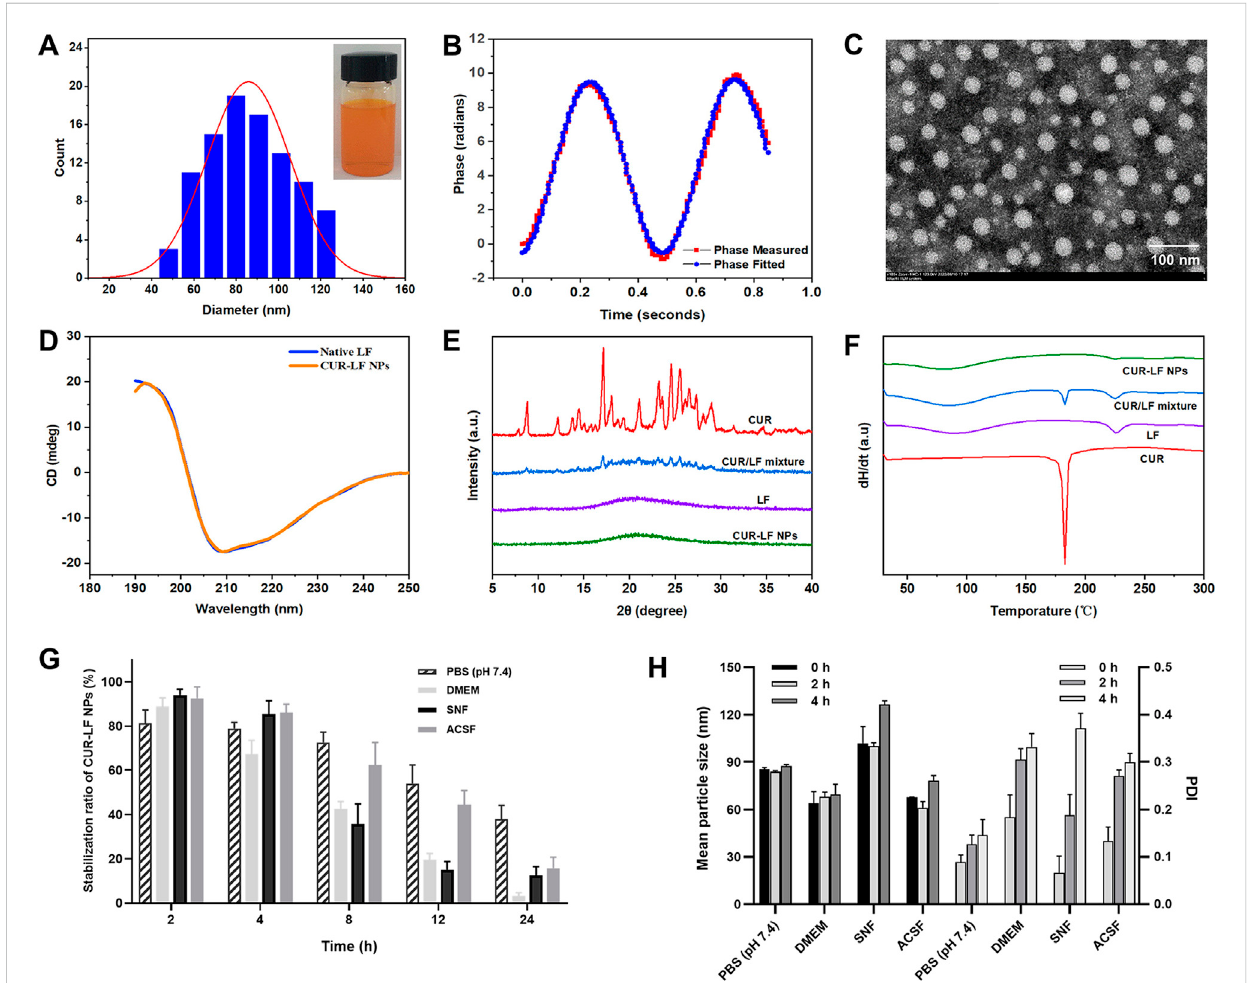
FIGURE 2 Characterization of CUR-LF NPs (A) Particle size distribution and appearance of CUR-LF NPs; (B) Zeta potential fi tting diagram of CUR-LF NPs; (C) Transmissionelectronmicroscopy(×100000)ofCUR-LFNPs; (D) DeterminationofsecondarystructureofnativelactoferrinandCUR-LFNPsbycircular dichroism; (E) X-ray diffractogram of curcumin, lactoferrin, curcumin/lactoferrin physical mixture, and CUR-LF NPs; (F) Differential scanning calorimetry ofcurcumin,lactoferrin,curcumin/lactoferrinphysicalmixture,andCUR-LFNPs; (G) EvaluationofthestabilizationratioofCUR-LFNPsincubatedin PBS (pH 7.4), Dulbecco ’ s modi fi ed Eagle medium (DMEM), simulated nasal fl uid (SNF), and arti fi cial cerebrospinal fl uid (ACSF) for 24 h; (H) Evaluation of the mean particle size and polydispersity index of CUR-LF NPs incubated in PBS (pH 7.4), DMEM, SNF, and ACSF for 4 h. Data were presented as mean ± SD ( n =